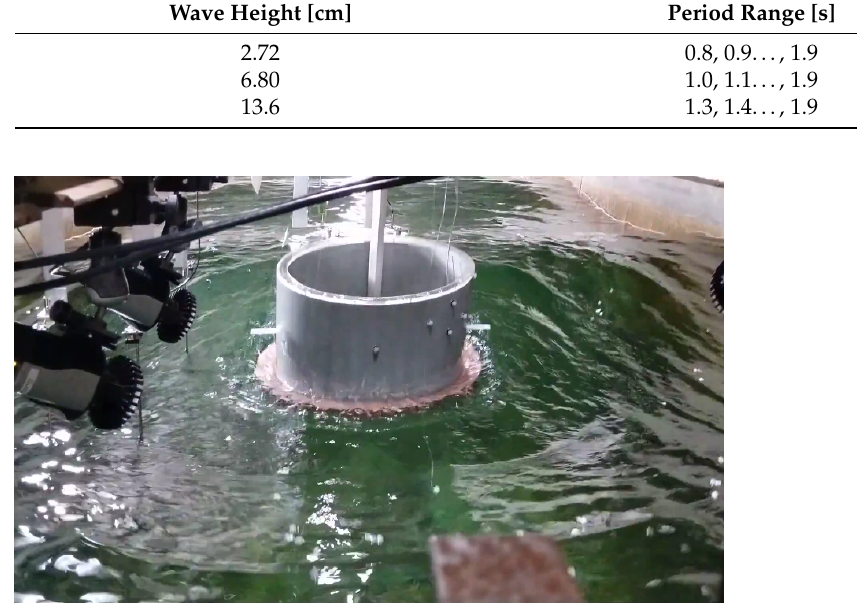
Figure 4. Picture of the reduced scale model during regular wave tests in the towing